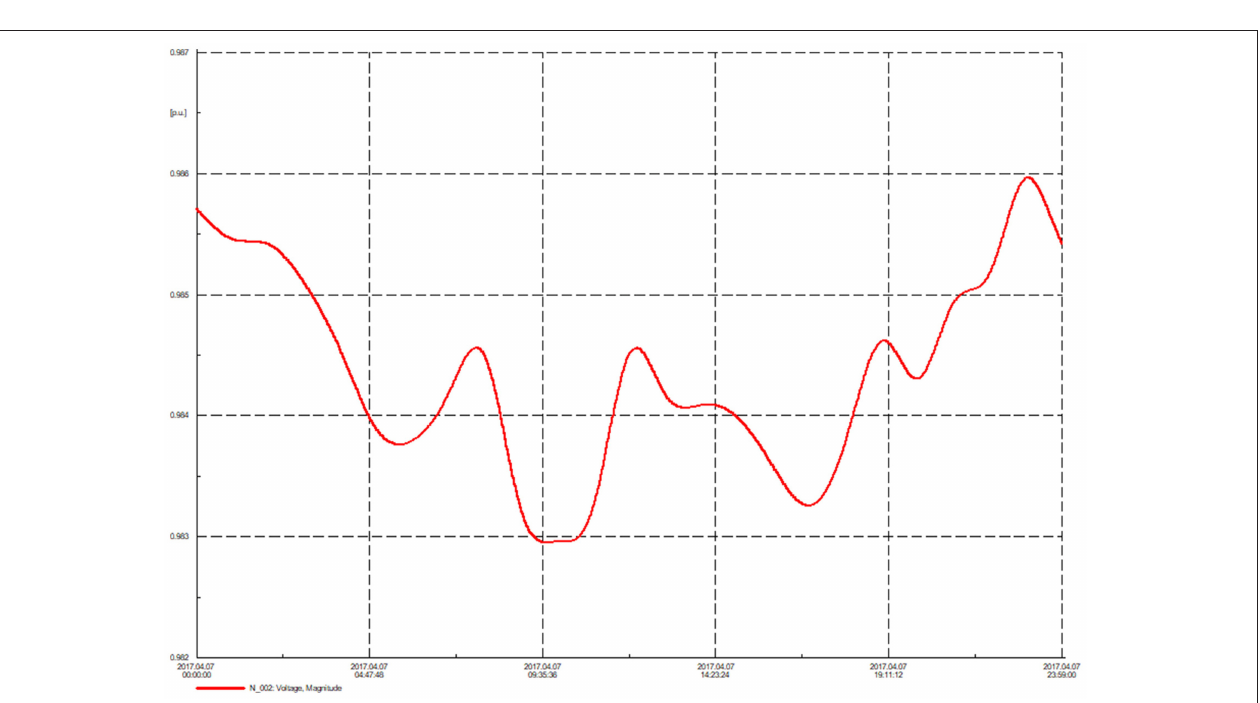
FIGURE 10 | Test case 1—with